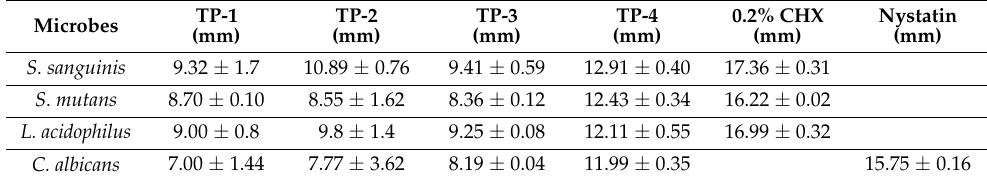
Table 1. ZOI for commercial TP1-4 against oral microbes.